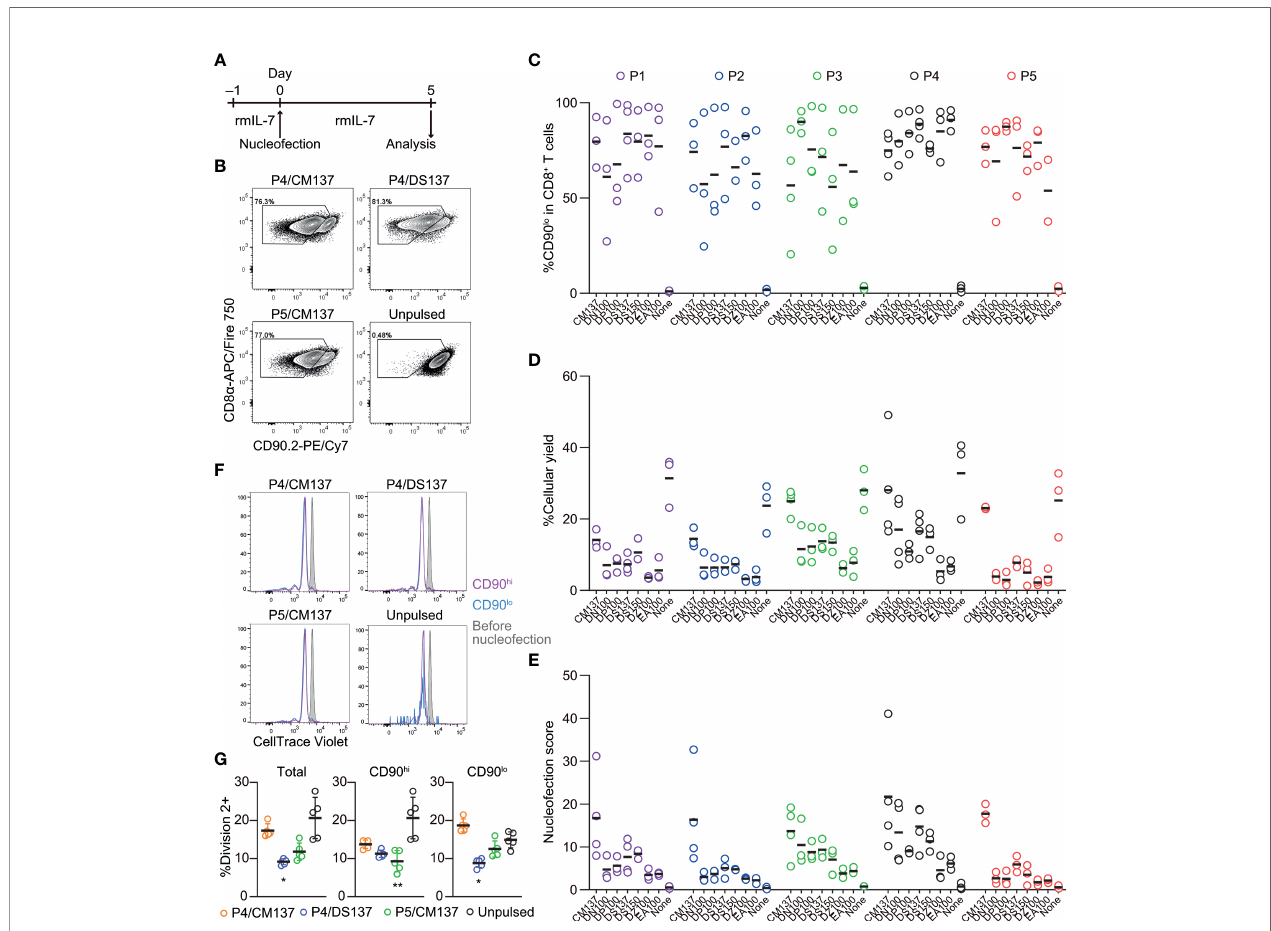
FIGURE 5 | Assessment of knockout ef fi cacy and cellular yield after CRISPR/Cas9 genetic engineering of naïve CD8 + T cells using nucleofection. (A) Experimental procedure. Magnetically isolated CD8 + T cells were kept in culture in the presence of rmIL-7 for 24 hr before nucleofection. Nucleofected cells were kept in culture for additional 5 days before analysis. (B) Representative plots from one experiment showing the downregulation of CD90 protein 5 days after nucleofection. Plots are gated on viable CD8 + T cells. (C, D) %CD90.2 lo in viable CD8 + T cells (C) and cellular yield (D) on day 2. (E) Nucleofection score calculated as [%CD90 lo ] × [%Yield]/ 100. Graphs show pooled data from 3 – 4 independent experiments. (F, G) Proliferation of CD8 + T cells after nucleofection. Cells were labelled with CellTrace Violet before placing them in culture on day – 1. Dilution of CellTrace Violet was measured by fl ow cytometry on day 5. Graph shows pooled data from fi ve independent experiments. * p < 0.05, ** p < 0.01 as compared to unpulsed control by Kruskal-Wallis test with Dunn ’ s multiple